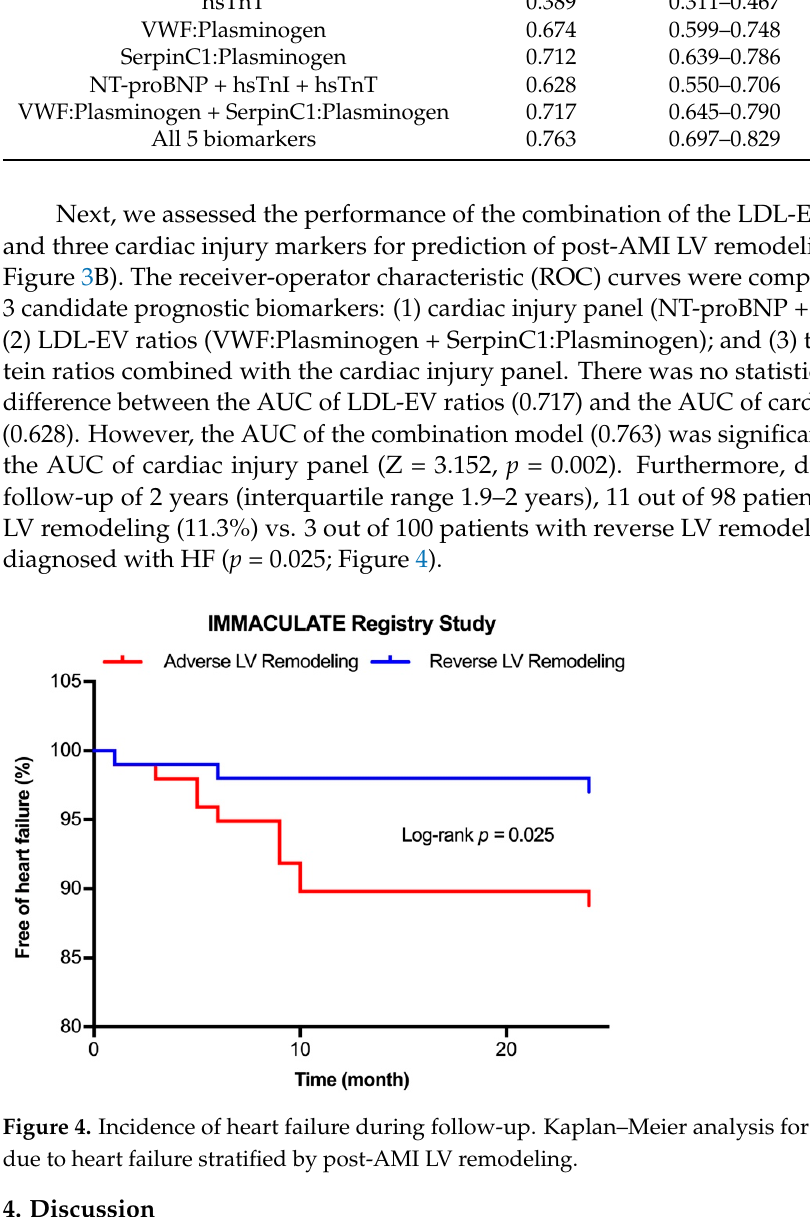
Table 4. Area under the receiver-operating curve (AUC) of different candidate markers predicting reverse LV remodeling.